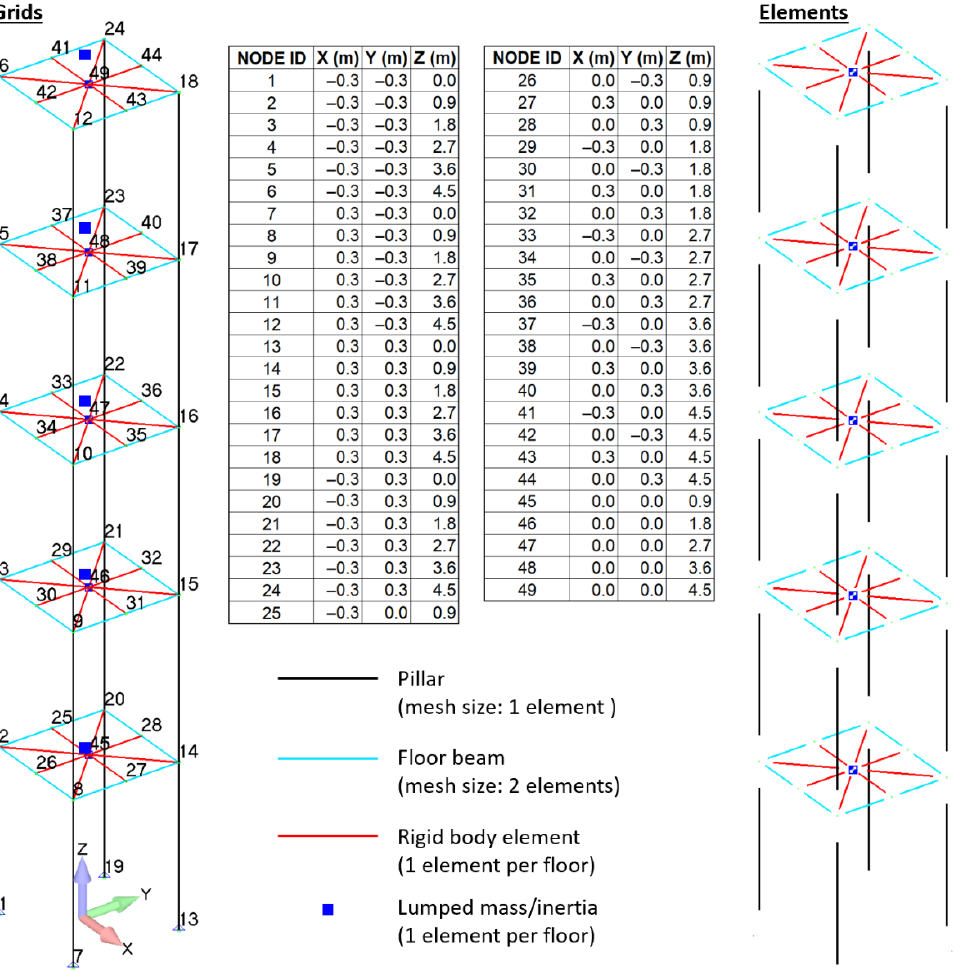
Figure 2. Seismic acceleration vs. time: real earthquake accelerogram ( left ); scaled accelerogram ( right ).